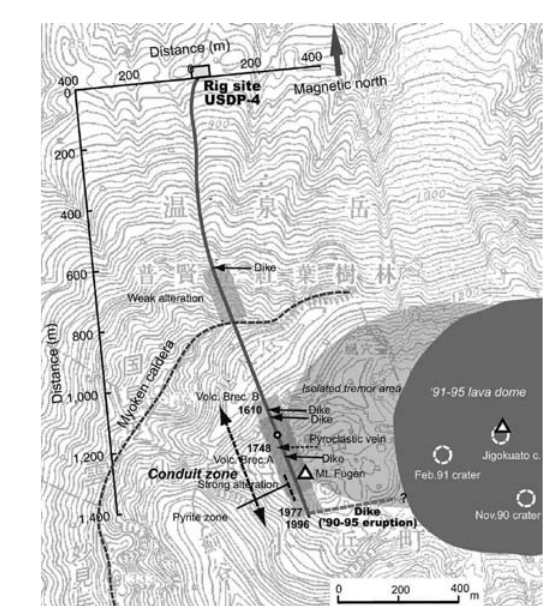
Figure 2. Vertical section along the USDP-4 well. Types A and B of the breccia are different in lithology (see Fig. 4). A lava dike that is considered to be the conduit of the 1990–1995 eruption was located at the deepest part of the